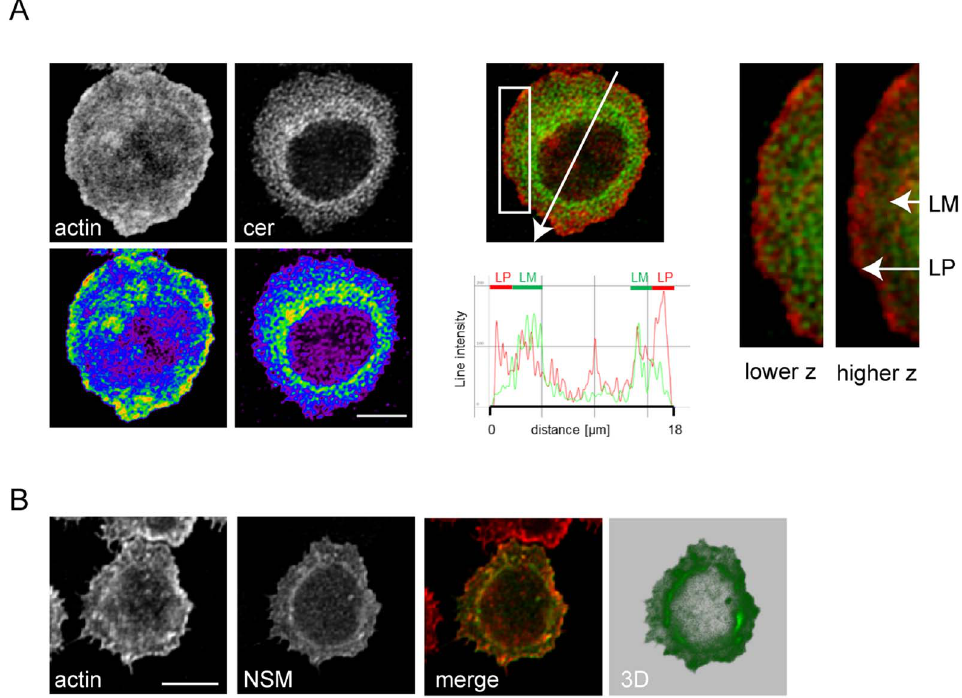
Fig. 2. Ceramide and NSM2 accumulate within the lamellum in co-stimulated T cells. A. Ceramide and f-actin were co-detected in T cells 15 min after seeding onto co-stimulatory slides (left panels, with intensities indicated by false colour representation, bottom panels). Size bar: 5 m m. Subcellular distribution of actin (in red) and ceramide (in green) within the lamellum (LM) or the lamellipodium (LP) are representatively shown as profiles (middle panel, intensity profile plane indicated by the arrow) or blow ups imaged at lower or higher z planes (distance approximately 600 nm)(right panels, enlargements of boxed area middle panel). B. NSM2 and f-actin were co-detected 24 h following nucleofection of p-NSM2-GFP (NSM2: green, f-actin: red). Subcellular distribution of NSM2-GFP is shown after deconvolution and 3D reconstruction (right panel). Size bar: 5 m